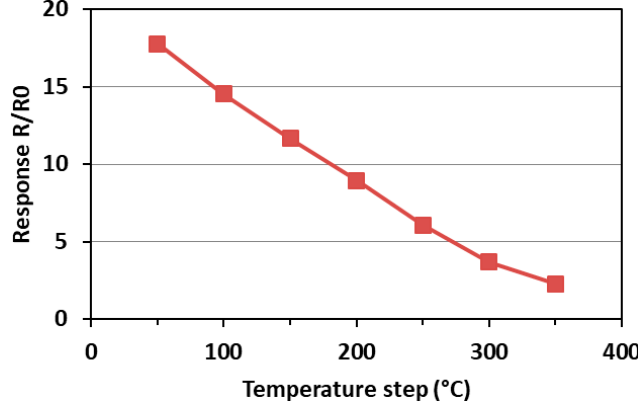
Figure 2. Response of ZnO:Ga vs. temperature step (in cycled temperature